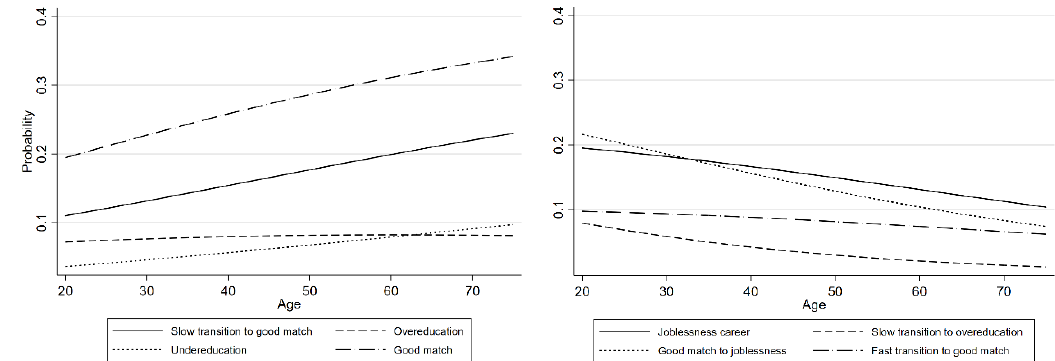
Figure 5. Predicted probabilities by mismatch career trajectory and age (average marginal effects). Estimated from multinomial logistic regression model in Table A3 in the Appendix A.